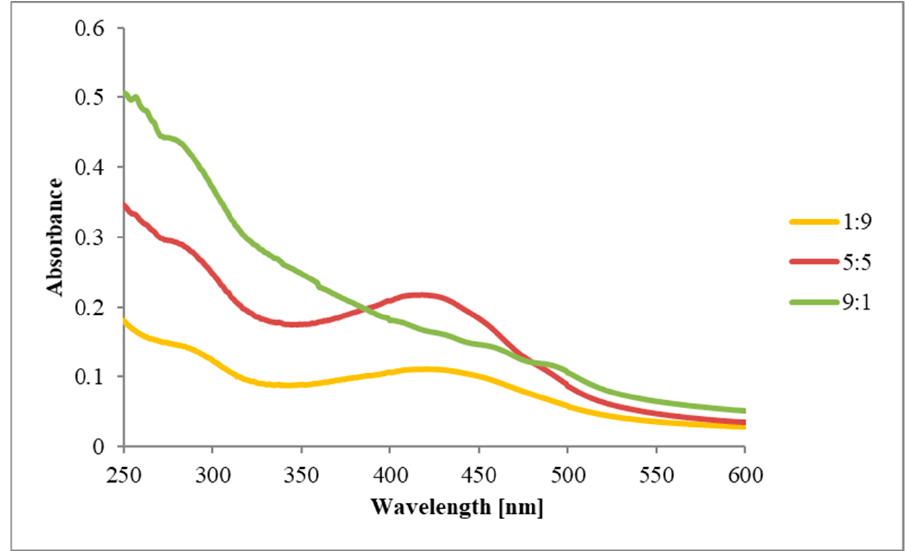
Figure 4. The influence of different plant extract:AgNO 3 ratios (1:9, 5:5 and 9:1) on AgNPs-EtOH formation.